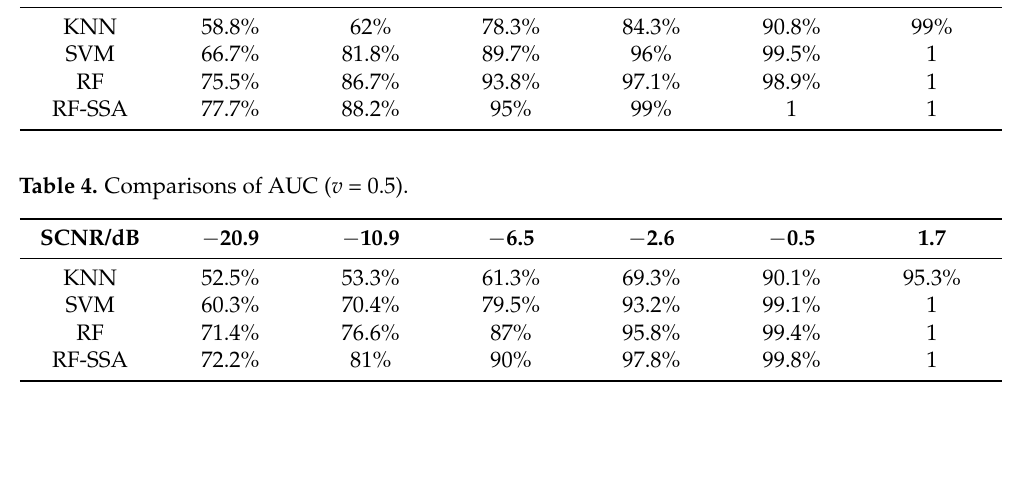
Table 3. Comparisons of AUC ( v = 0.1).